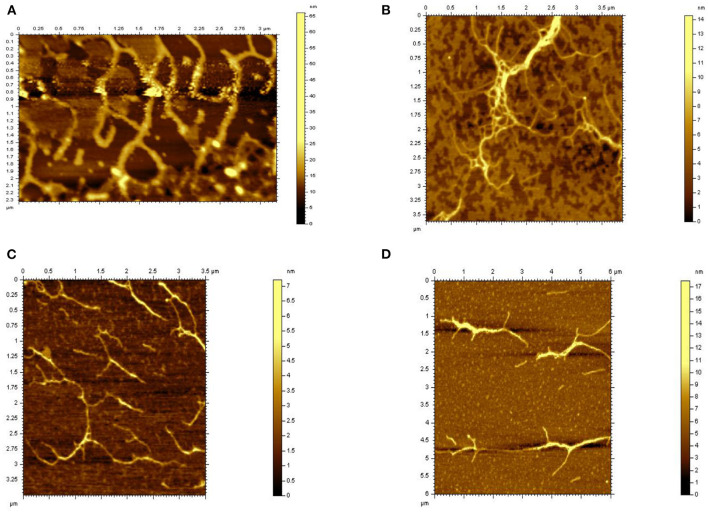
AFM microscopy of HEBGs [(A) is HEBG; (B) is HEBG-1; (C) is HEBG-2; (D) is HEBG-3].